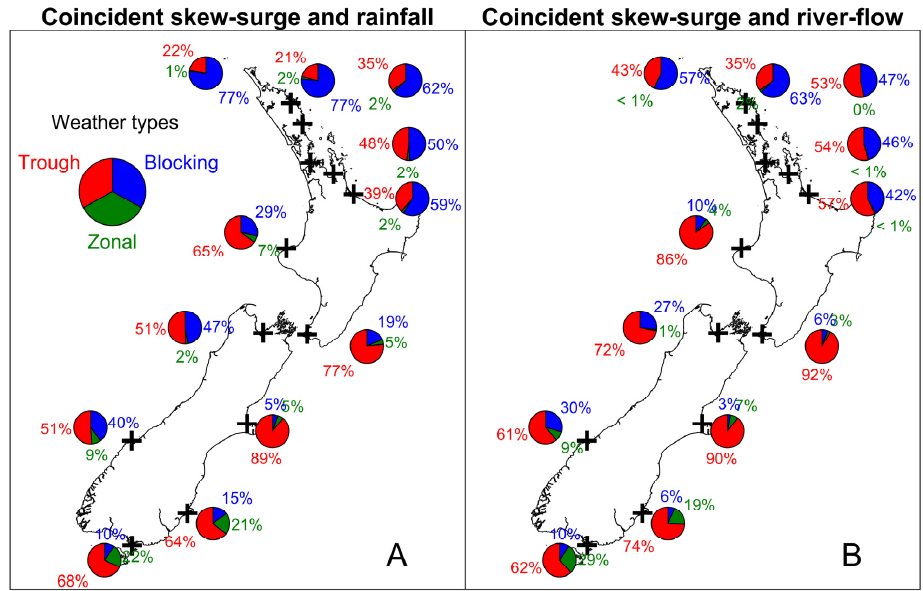
Figure 10. Pie charts showing weather type causing composite skew-surge, rainfall, and river-flow events. Skew-surge and rainfall events, > 95th percentile. Skew-surge and river-flow events, > 90th percentile. Colors refer to Kidson type: red = trough, green = zonal, and blue = blocking. Rainfall and coincident events chosen within 30 km of one another. ( A ) Coincident skew-surge and rainfall, ( B ) Coincident skew-surge and river-flow.